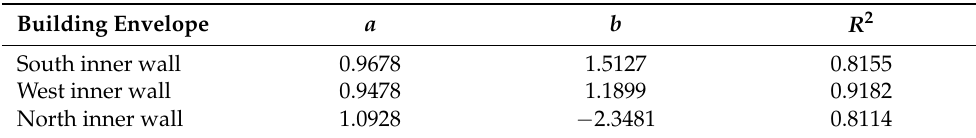
Table 3. Approximate coefficients for the surface temperature of the building envelope and the indoor air temperature.